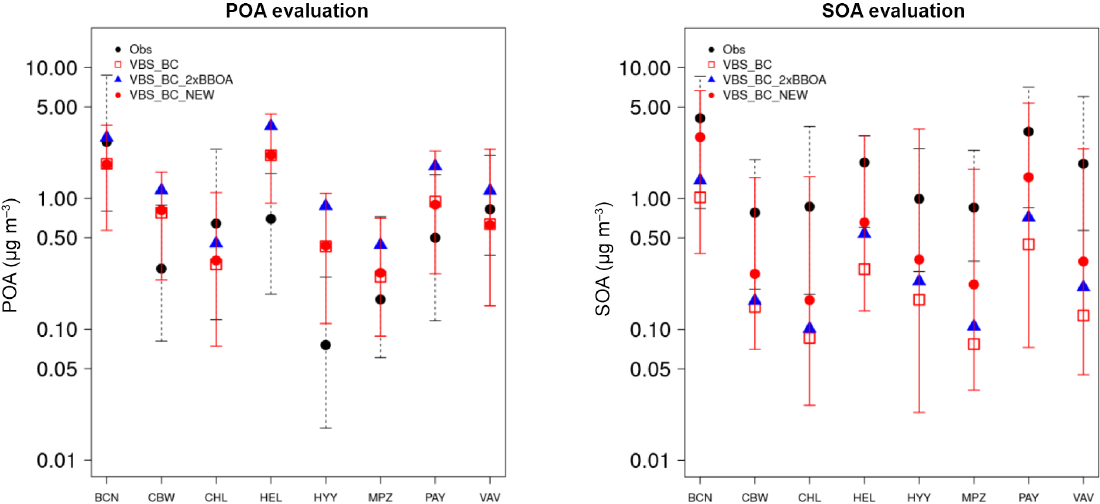
Figure 10. POA (left) and SOA (right) median concentrations at eight AMS sites for February–March 2009 in the VBS_BC, VBS_BC_2xBBOA and VBS_BC_NEW cases. Dotted lines indicate the 10th and 90th quartile range (also reported in red for the VBS_BC_NEW case). Data for the Puy de Dôme and Montseny sites at higher layers are not available for the VBS_BC_2xBBOA sce- nario.